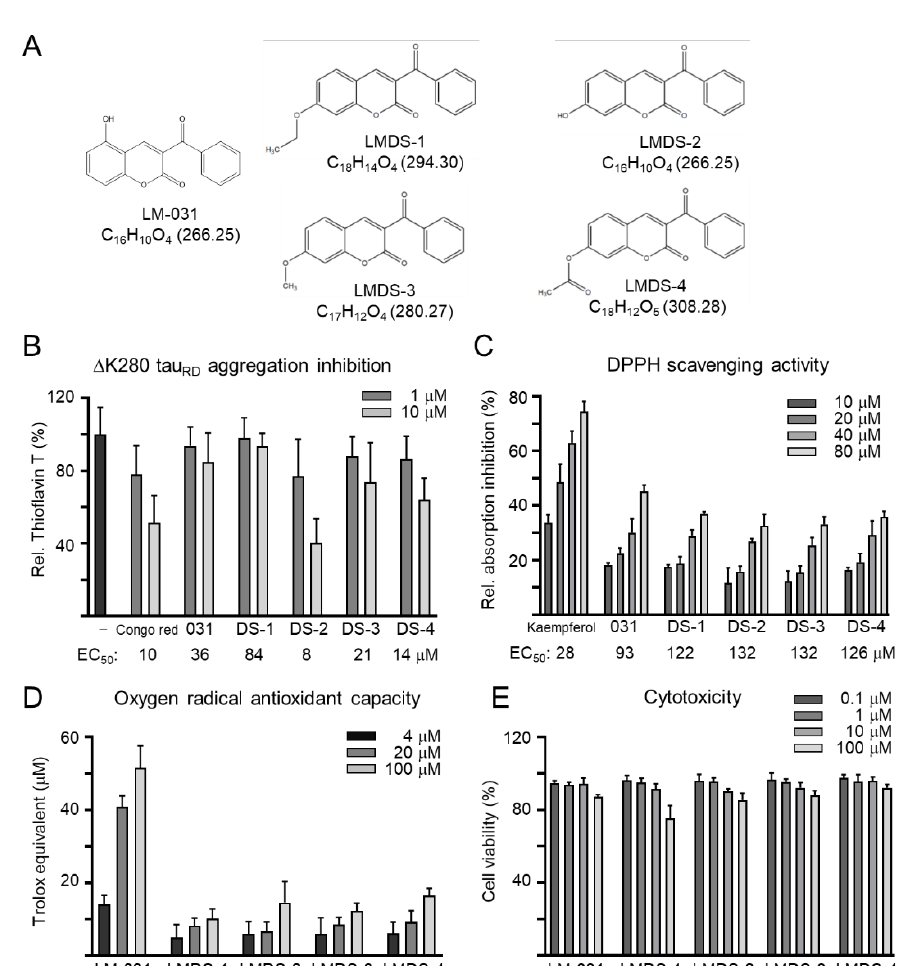
Figure 1. Tested coumarin compounds. ( A ) Structure, formula and molecular weight of LMDS-1 to -4 and LM-031. ( B ) ∆ K280 tau RD aggregation inhibition of Congo red (as a positive control), LM-031 and LMDS-1 to -4 (1–10 µ M) by the thioflavin T assay ( n = 3). To normalize, the relative thioflavin T fluorescence of ∆ K280 tau RD without compound treatment was set at 100%. Shown below are the EC 50 values. ( C ) Free radical-scavenging activity of kaempferol (as a positive control), LM-031 and LMDS-1 to -4 (10–80 µ M) on DPPH ( n = 3). Shown below are the EC 50 values. ( D ) Oxygen radical absorbance capacity of LM-031 and LMDS-1 to -4 (1–100 µ M) ( n = 3). ( E ) Cytotoxicity of LM-031 and LMDS-1 to -4 against ∆ K280 tau RD -DsRed SH-SY5Y cells examined using the MTT assay. Cells were treated with each test compound (0.1–100 µ M) and cell viability was measured the next day ( n = 3). To normalize, the relative viability of untreated cells was set at 100%.